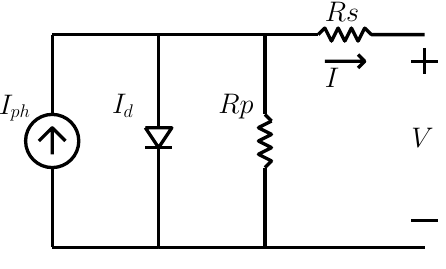
Figure 1. Single diode model circuit.